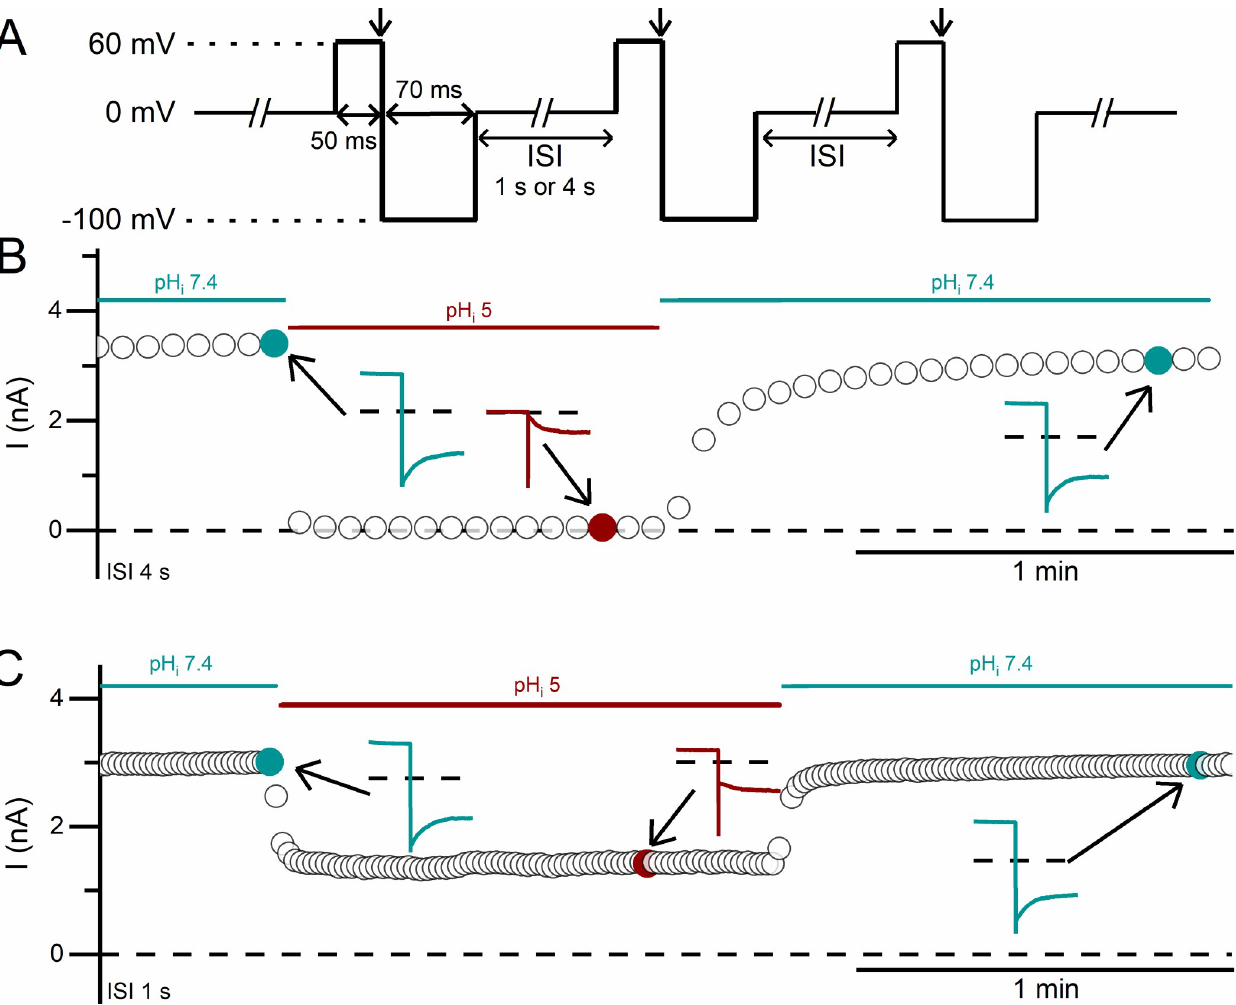
Fig 3. Inhibition of WT CLC-0 by intracellular H + . (A) Voltage protocol (protocol II) used for the experiments. (B & C) Inhibition of the CLC-0 current by an intracellular acidic solution (pH i = 5). Circles represent the current measured at the steady state of the +60 mV voltage step as indicated by the downward arrows shown in A. ISI = 4 s and 1 s for the experiments in B and C, respectively. Notice the incomplete inhibition when ISI = 1 sec. Insets show traces for recording sweeps at the indicated time